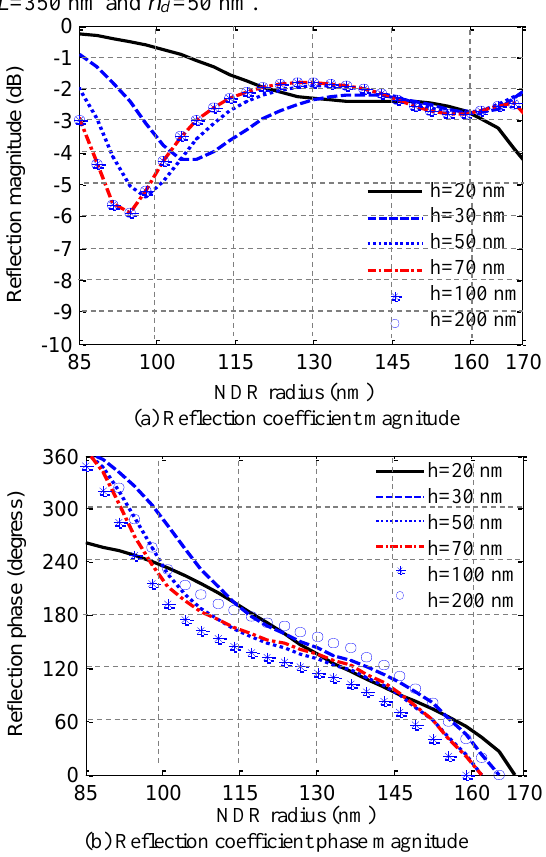
Figure 6 The variations of the reflection coefficient magnitude and phase versus the NDR radius of the unit cell with silver supporting plane at different plate thickness h, at L =350 nm, h d =50 nm.